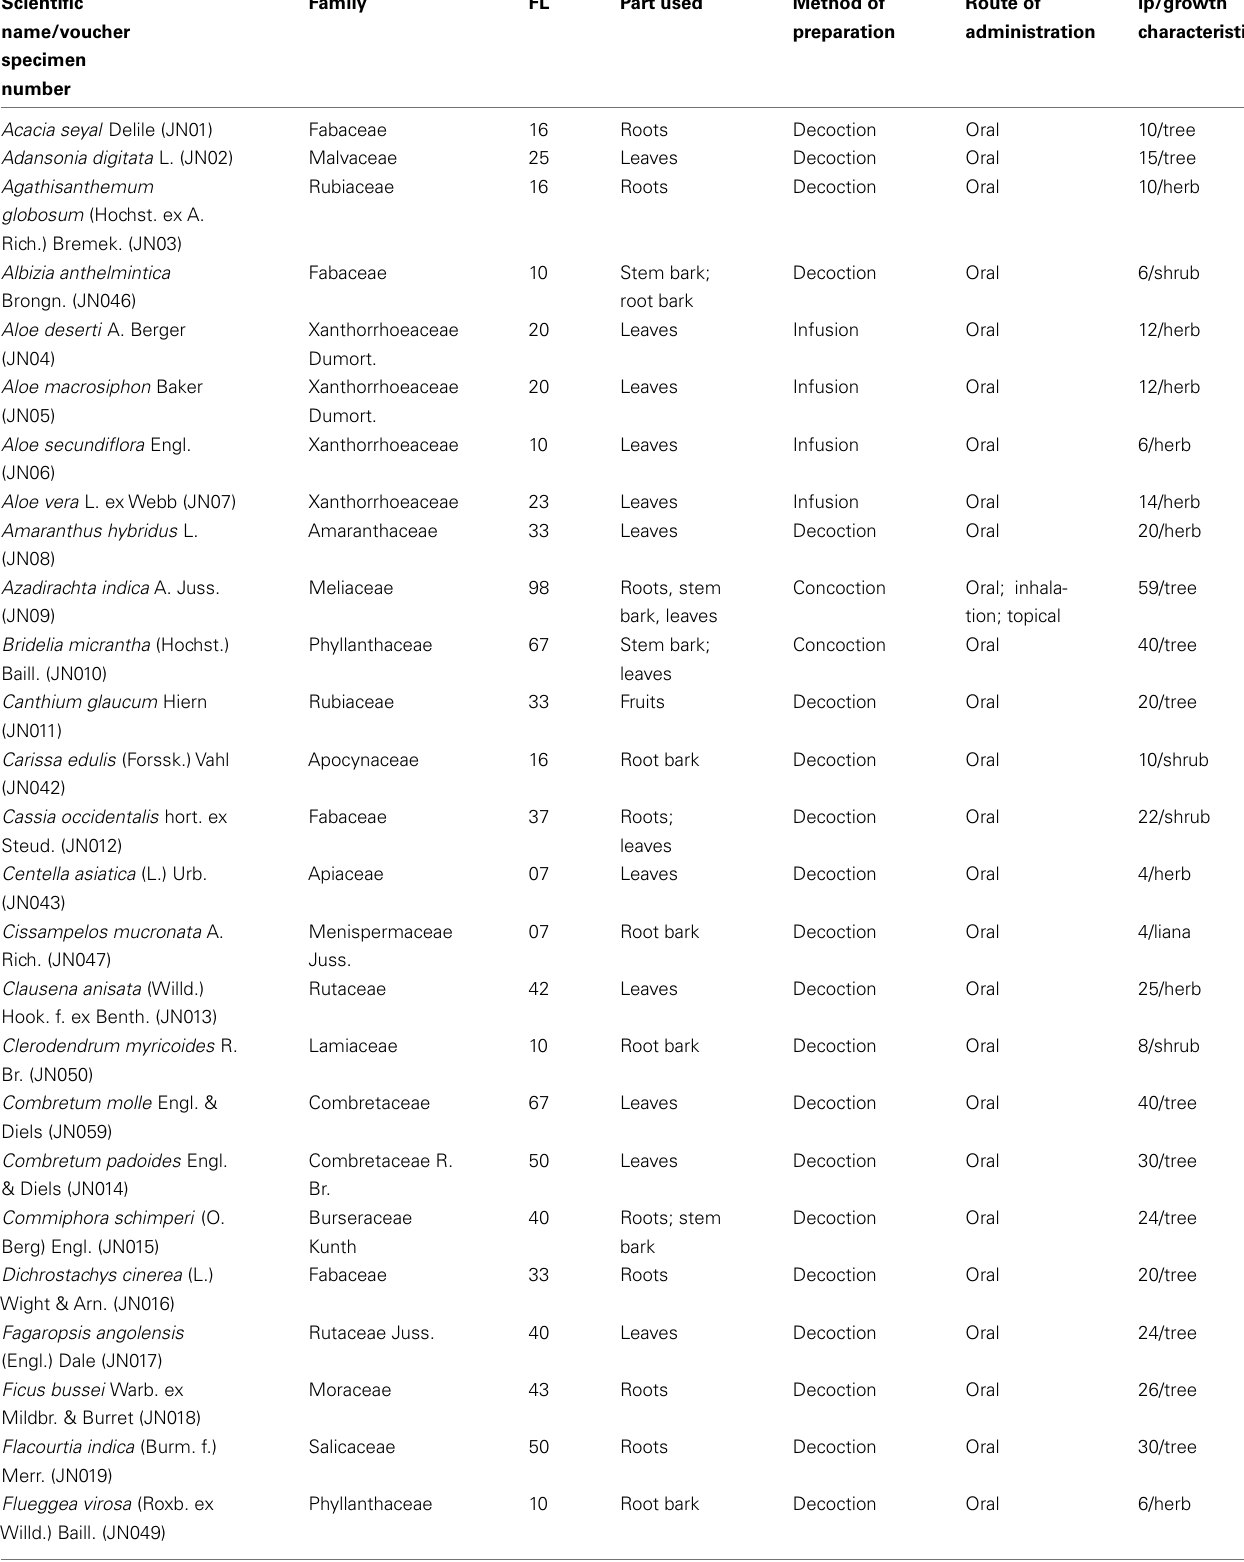
Table 3 | Plant species commonly reported by Digo people for the treatment of malaria in Diani location ( n =